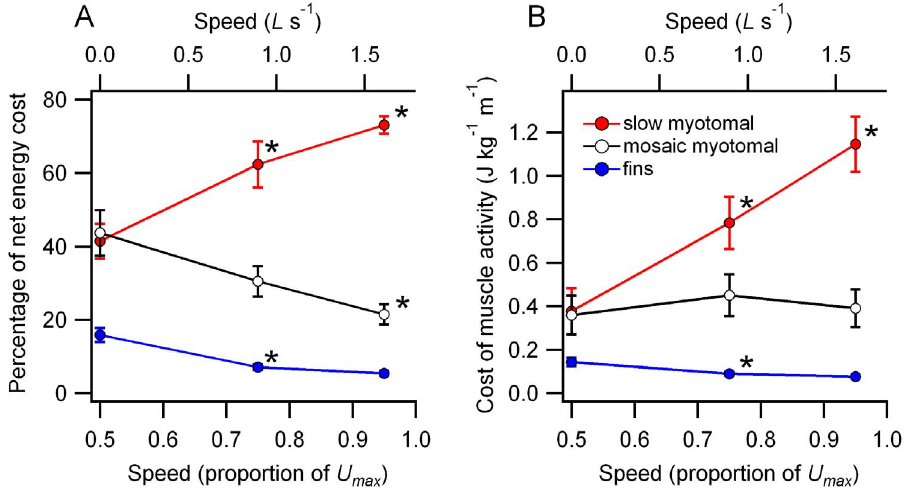
Figure 4. A. Estimated percentage of swimming energy costs directed to the myotomal and fin musculature during steady swimming. B. Estimated net cost of transport associated with activity in the myotomal and fin musculature. Data are shown as mean 6 sem (N=6 to 8). * designates a significant change relative to the adjacent lower speed condition.